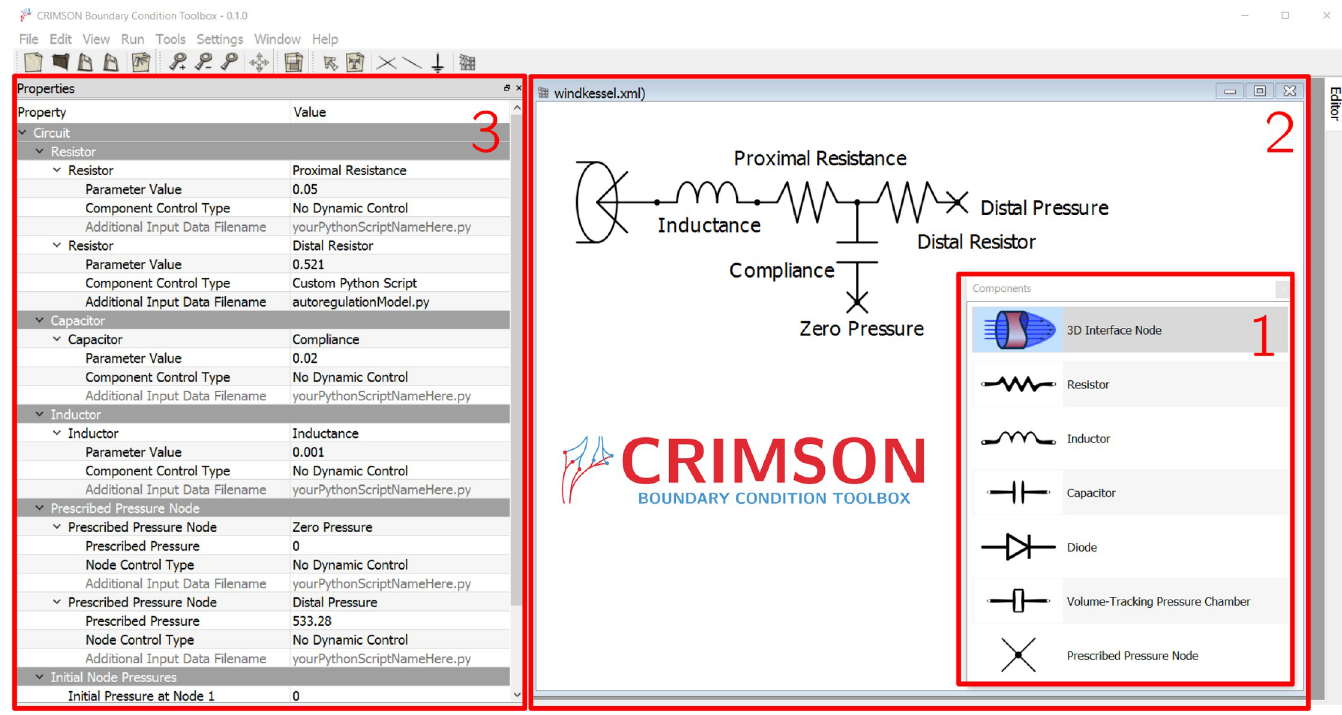
Fig 3. The CRIMSON Boundary Condition Toolbox. Researchers can use this tool to design custom LPN boundary condition models by choosing and arranging components from the toolbox (1) on the workplane (2). Parameters and other component properties can be set in the Properties pane (3). Here, a depiction of a Windkessel model is being